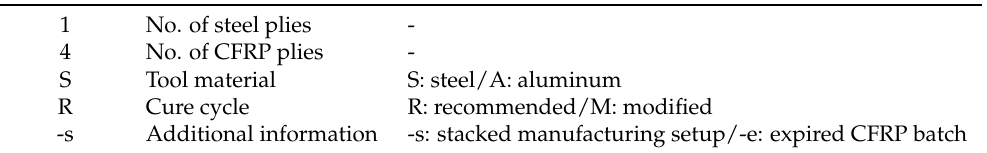
Table 6. Explanation of the logic that is used to label every specimen manufactured, using the specimen with ID14SR-s as an example.